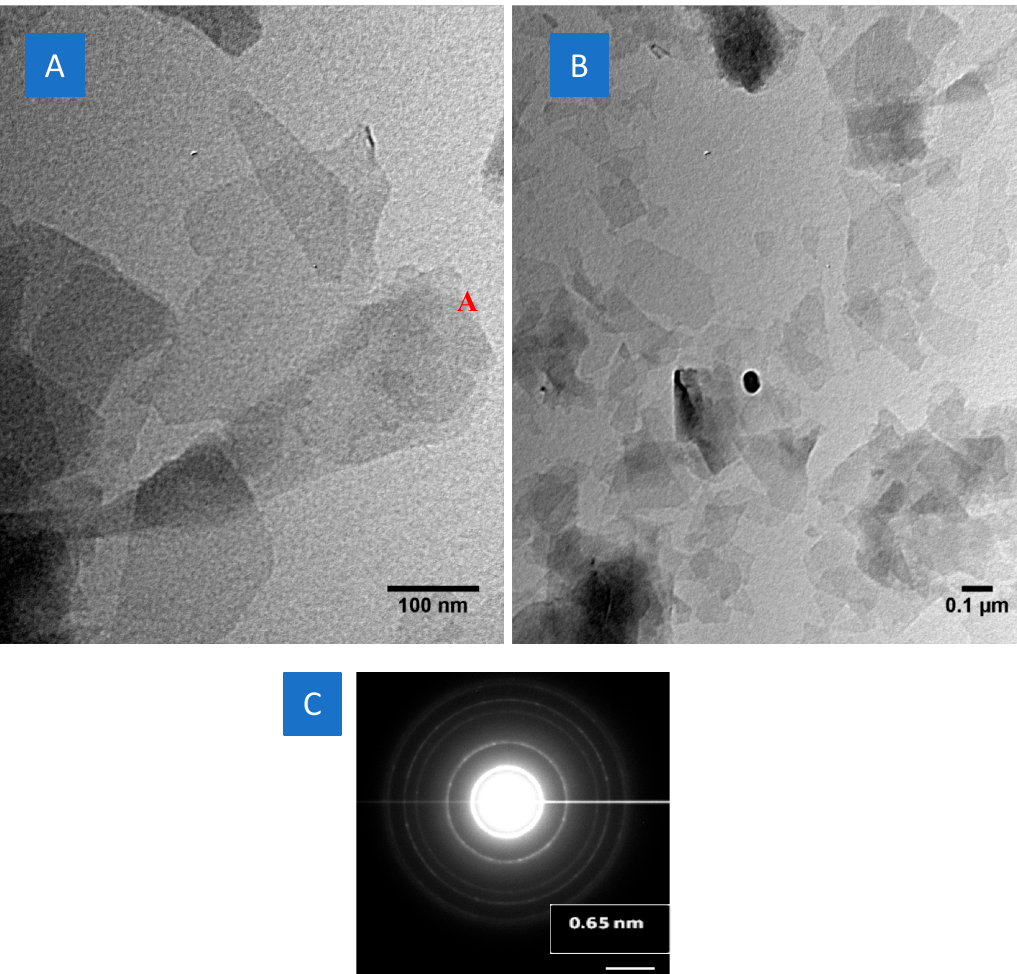
Figure3. TransmissionElectronMicroscopy(TEM)micrographofnC4at( A )150,000timesmagnification, Figure 3. Transmission Electron Microscopy ( TEM) micrograph of nC4 at ( A ) 150,000 times ( B ) 50,000 times magnification and, ( C ) TEM-di ff raction pattern of magnification, ( B ) 50,000 times magnification and, ( C ) TEM ‐ diffraction pattern of nC4.